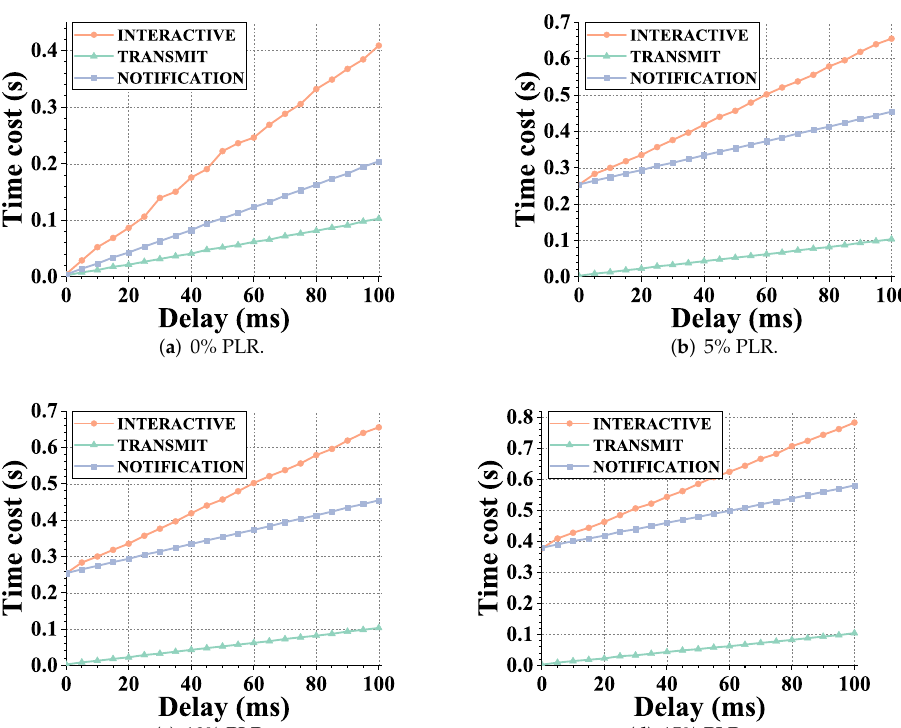
Figure 12. The handover latency results under different link settings. The abscissa represents different link delay settings, and the subgraph represents different link packet loss rate settings. Handover latency is defined as the time cost between the GW reacquiring the address, updating the binding with the CS, and re-negotiating the shared key defined as the handover latency. ( a ) Packet loss rate = 0%, ( b ) packet loss rate = 5%, ( c ) packet loss rate = 10%, and ( d ) packet loss rate =